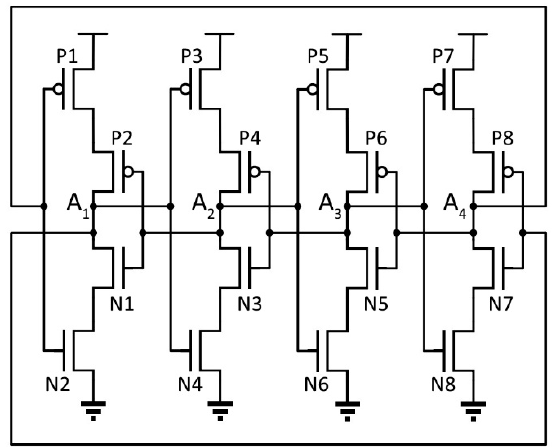
Figure 6. Guard gate DICE latch schematic.